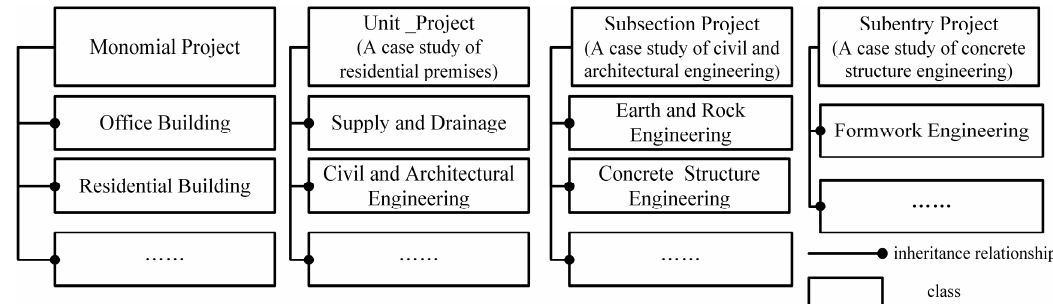
Figure 2. Example of the concept representation of project classifications.